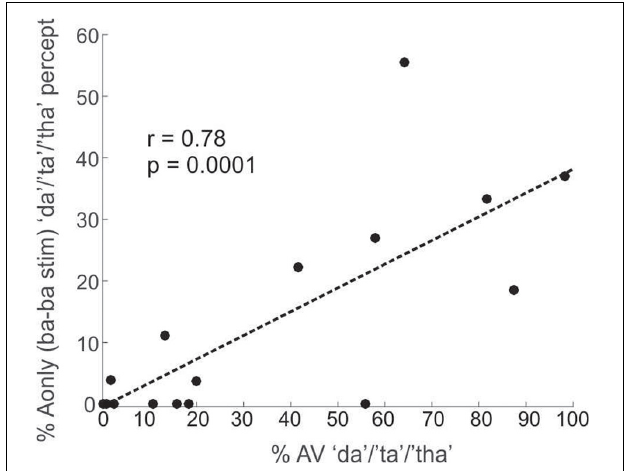
FIGURE 5 | A plot depicting the correlation between percentages of “da”/“ta”/“tha” responses to the A-only /ba–ba/ stimuli (superimposed /ba/ and /ba/ CVs) and the overall response percentages of the “da”/“ta”/“tha” percept during the AV condition. These data are from